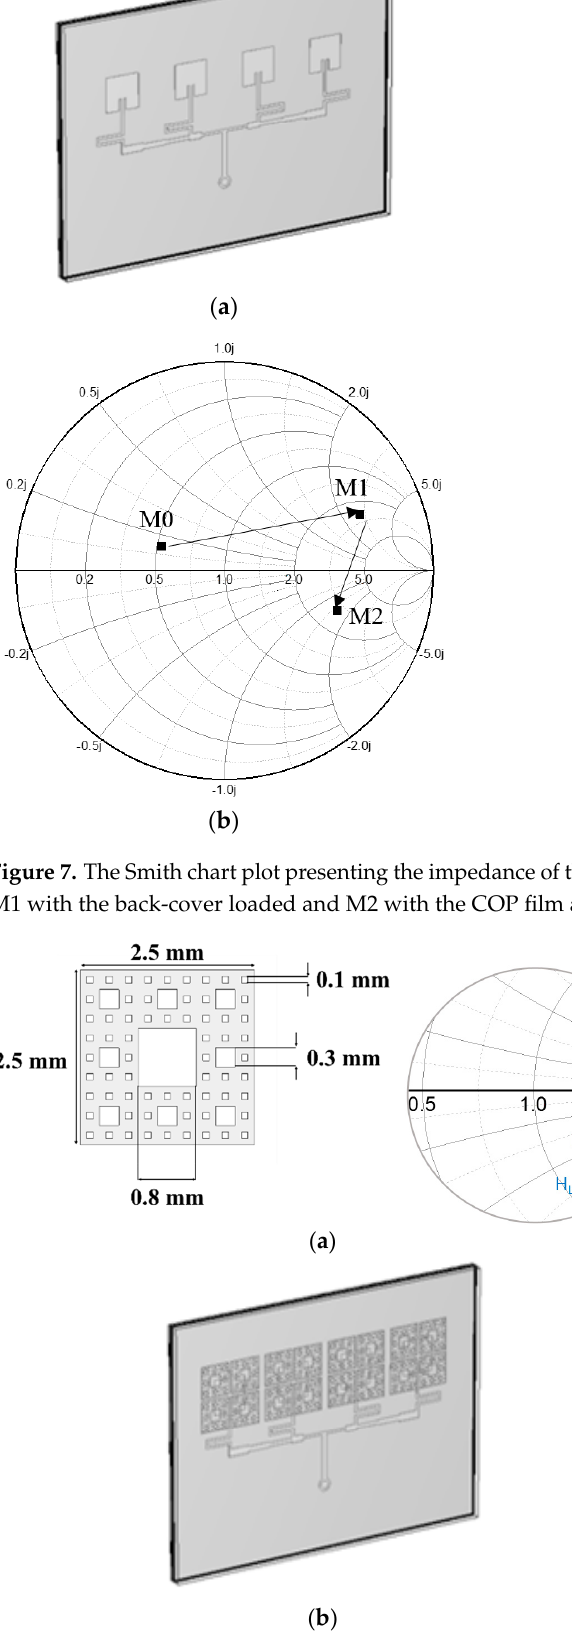
Figure 7. The Smith chart plot presenting the impedance of the resonator array: M0 as the array alone, M1 with the back − cover loaded and M2 with the COP film added. ( a ) Structure. ( b ) Smith chart.